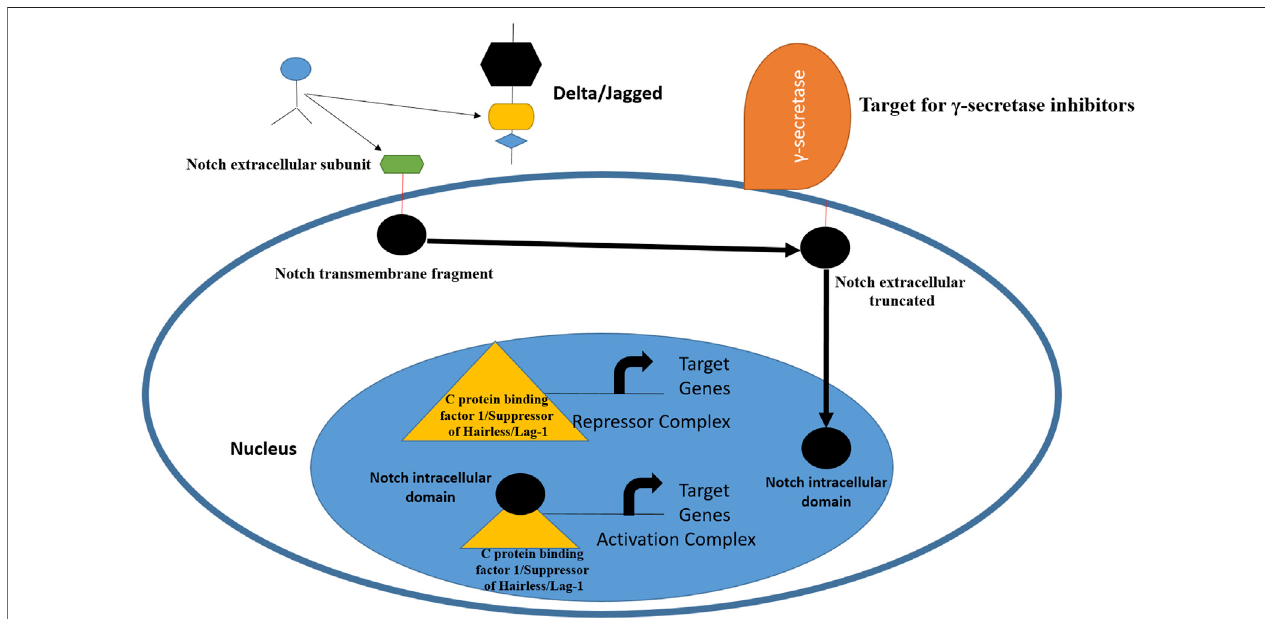
FIGURE 1 | Schematic representation of Notch receptor activation and avenues for therapeutic intervention. The pathway is activated by ligand binding to Notch receptor,followedbyproteolyticcleavagefyproteases.ThisreleasestheNotchintracellulardomain,whichisthentransferredtonucleusforbidingwithCproteinbinding factor1/SuppressorofHairless/Lag-1allowingconversionofcomplexfromrepressortoactivatorofNotchgenes.Frominhibitionperspective, γ -secretaseinhibitorsand monoclonal antibodies can inhibit Notch ligands and receptors (Yuan et al., 2015; Medina et al.,